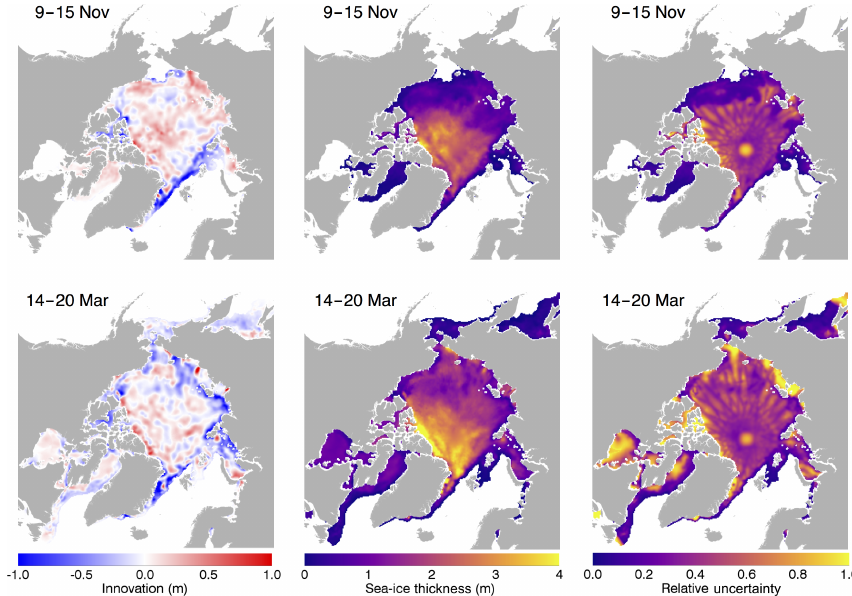
Figure 9. Optimal interpolation output grids for weeks in November 2015 and March 2016: the innovation field (left column) shows the difference between background field and the CS2SMOS ice thickness (center column). The right column shows the relative uncertainty associated with the optimal interpolation.